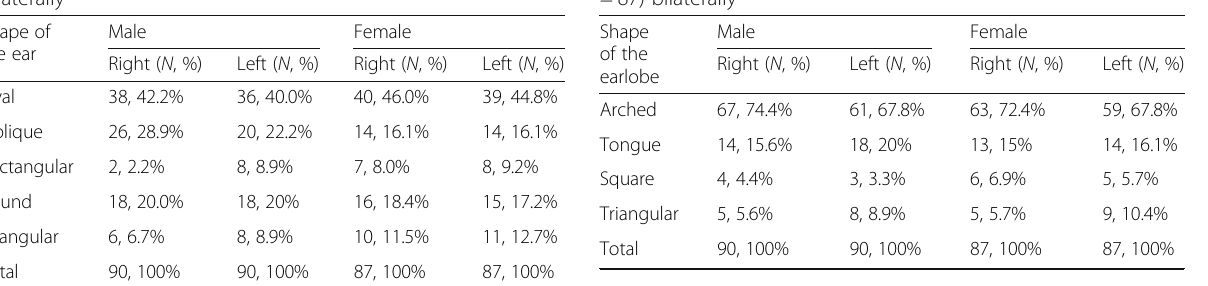
Table 3 Shape of the earlobe in males ( N = 90) and females (